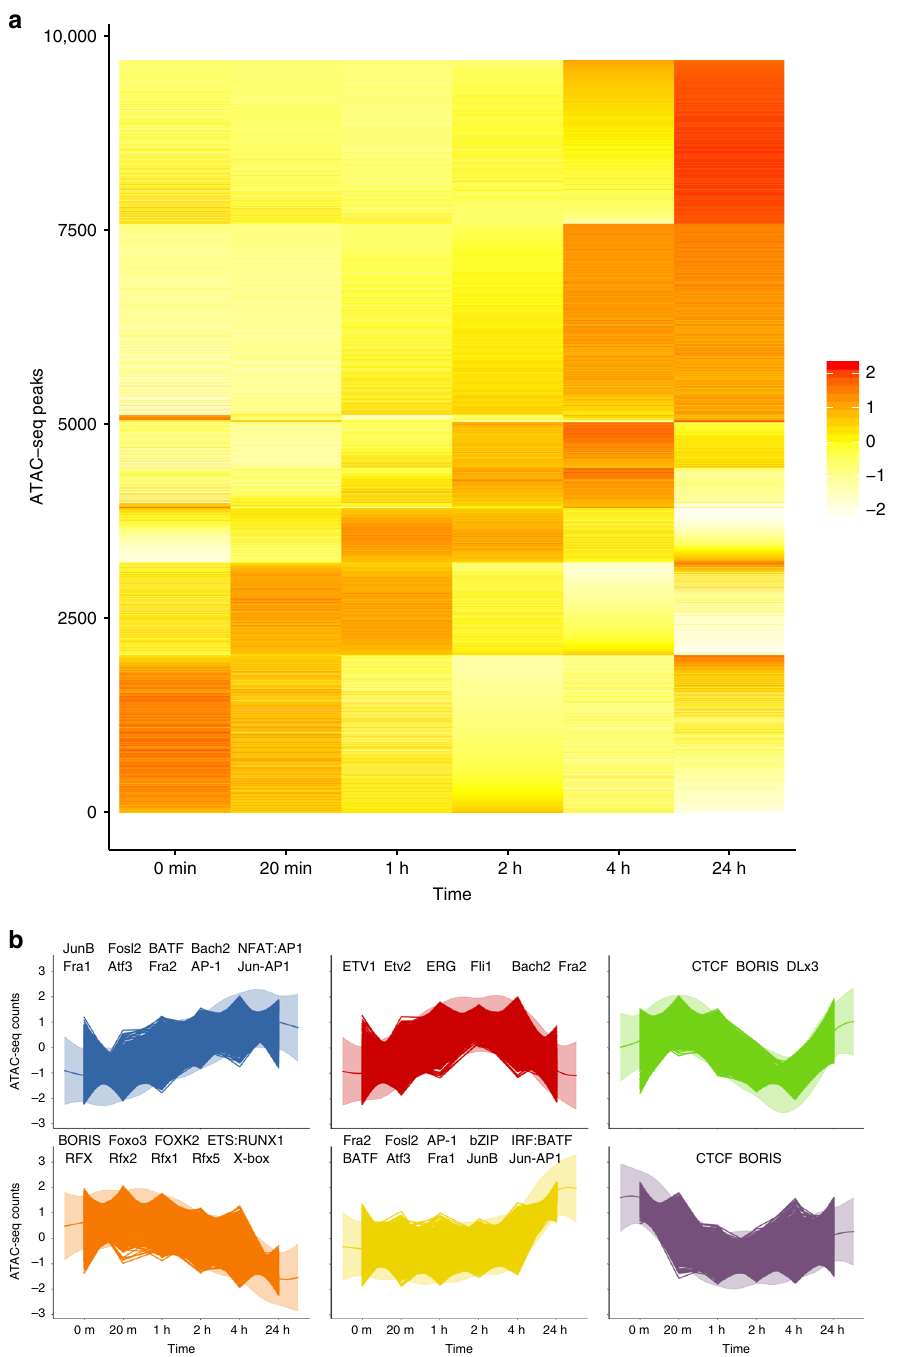
Fig. 3 Illustration of ATAC-seq time course pro fi le dynamics. a Heatmap of ATAC-seq counts data for peaks showing evidence of temporal dynamics. b Clustering of ATAC-seq time course data using a Gaussian process mixture model. Signi fi cantly enriched DNA-binding MOTIFs in each peak (using static peaks are background) are labelled in each